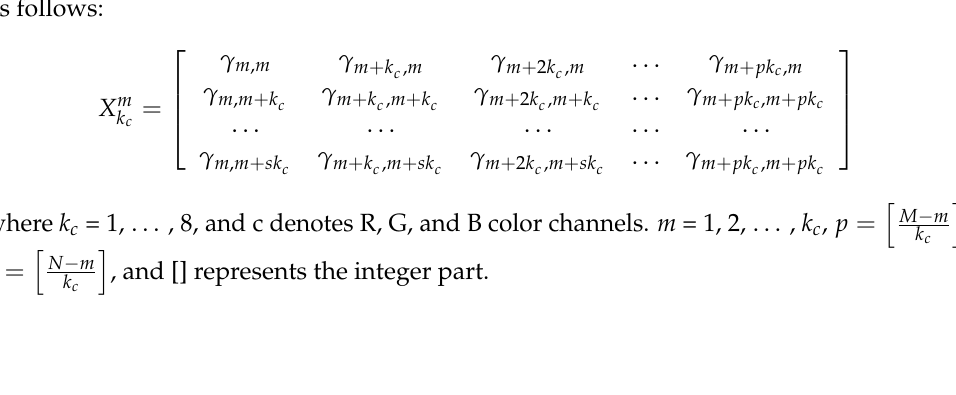
Figure 4. An example of the HFD computation. ( a – c ) R, G, and B color channels for a digital image that belongs to the PH2 dataset. ( d – i ) An illustration of the tessellation patterns for each color channel. The triangle shapes of k = 1 are presented in ( d – f ); the fractal scaling parameter k = 4 is shown in ( g , i ). They are used to compute the X m matrices. ( d , g ) are R channel images. ( e , h ) are G channel images. ( f , i ) are B channel